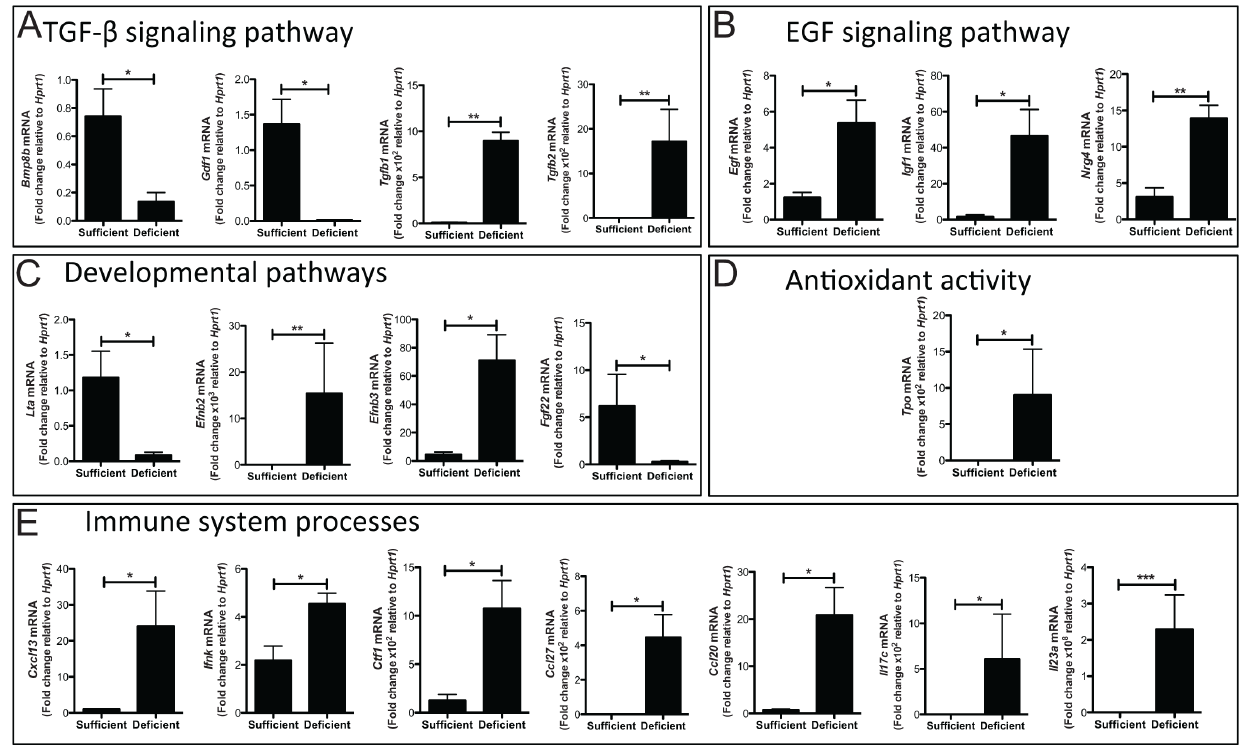
Figure 3. Cytokine expression is aberrantly regulated in selenium deficient mice post-DSS. A. mRNA expression changes in Se-sufficient (n=4) and -deficient (n=4) mice on from day nine of the DSS morbidity protocol. Genes were grouped based on pathways identified by PANTHER pathway analysis software. Expression was normalized to Hprt . A. TGF- b pathway alterations include Bmp8b=bone morphogenetic protein 8b, Gdf1=Growth differentiation factor-1, Tgf b 1=transforming growth factor beta-1, Tgf b 2=transforming growth factor beta-2. B. EGF pathway alterations include Egf=epidermal growth factor, Igf1=insulin-like growth factor 1, Nrg4=neuregulin 4. C. Developmental pathway alterations include expression changes in Lta=lymphotoxin alpha, Efnb2=ephrin-B2, Efnb3=ephrin-B3, Fgf22=fibroblast growth factor 22. D. The gene altered within the group titled antioxidant activity is Tpo=thyroid peroxidase. E. Immune system process alterations are demonstrated in Cxcl13=chemokine (C-X-C motif) ligand 13, Ifnk=interferon kappa, Ctf1=cardiotrophin 1, Ccl27=chemokine (C-C motif) ligand 27, Ccl20=chemokine (C-C motif) ligand 20, IL17c=interleukin 17c, IL23a=interleukin 23a.-- * P , 0.05, ** P , 0.01, *** P , 0.001.